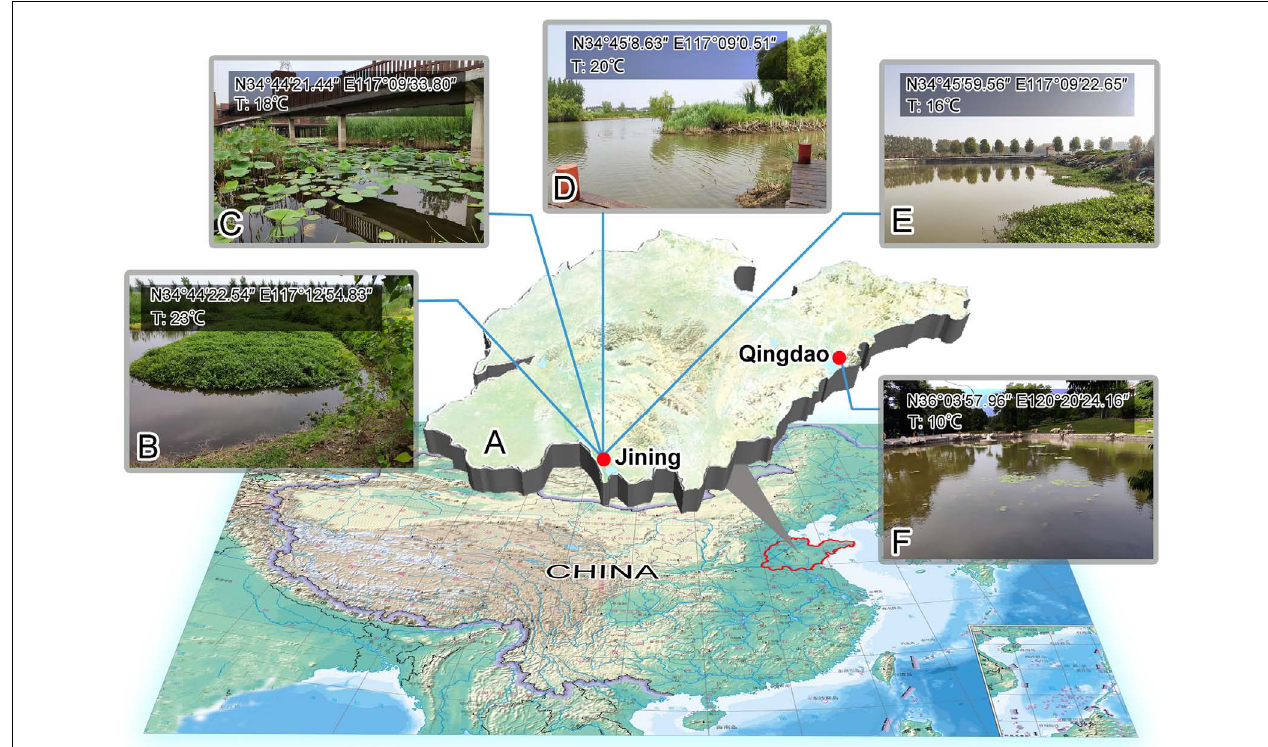
FIGURE 1 | Sampling sites. (A) Map of Shandong Province to indicate the locations of the sampling sites. (B) Sampling site of Zoothamnium weishanicum n. sp., Jining. (C) Sampling site of Zoothamnium arbuscula , Jining. (D) Sampling site of Zoothamnium hentscheli , Jining. (E) Sampling site of Epicarchesium sinense n. sp., Jining. (F) Sampling site of Carchesium polypinum , Qingdao. T,